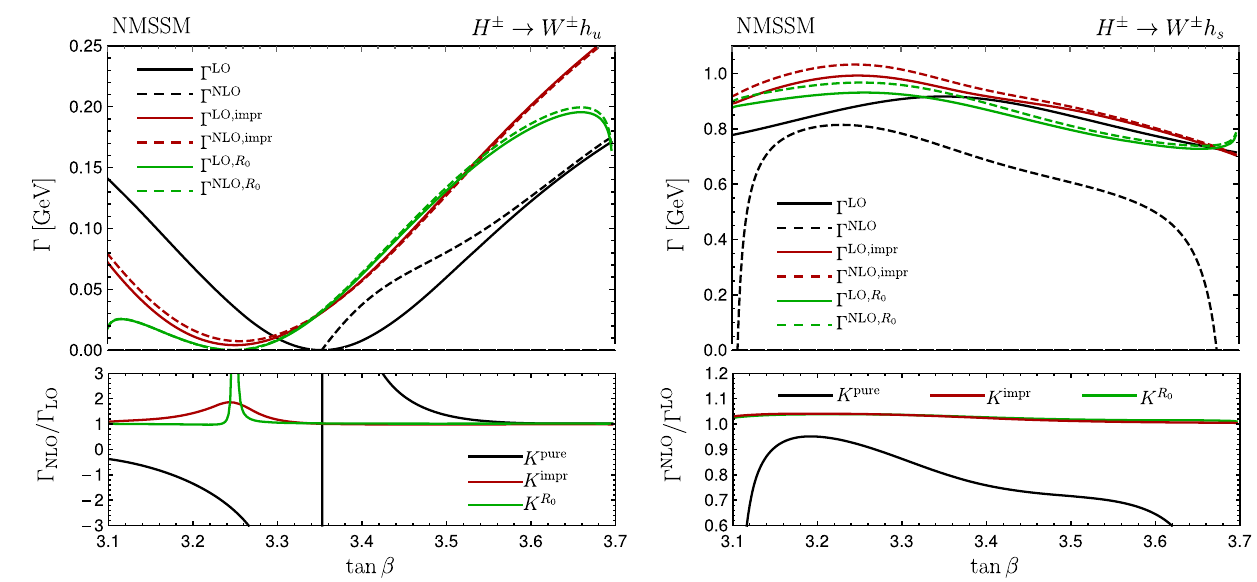
Fig. 13 Parameter point P1: partial decay width of the decay H ± → W ± h u (left)and H ± → W ± h s (right)atLO(full)andNLO(dashed)at strict LO and one-loop order (black), in the improved approach apply-